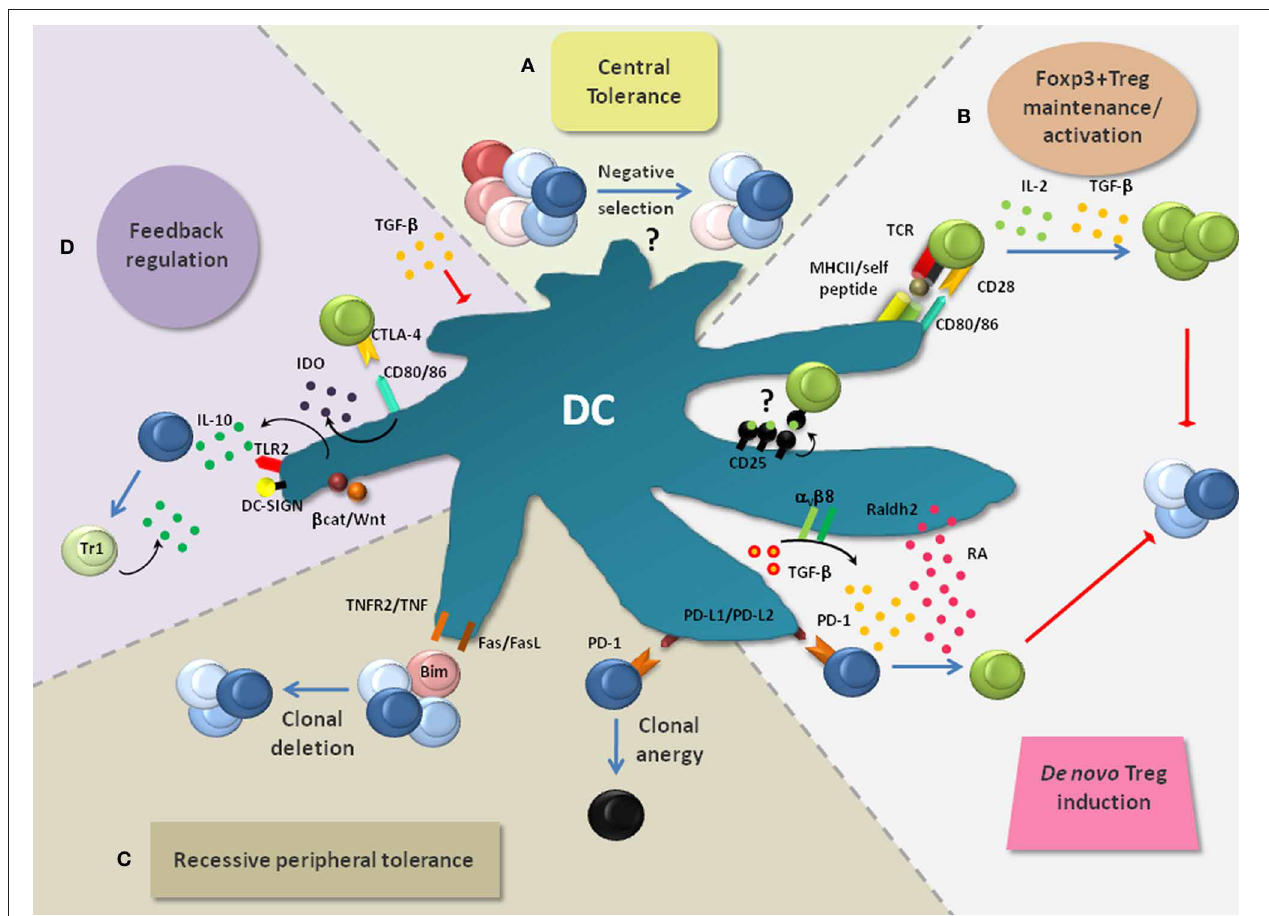
FIGURE 2 | Layers of DC-mediated tolerance. DCs promote tolerance via multiple layers, thereby rendering the term “tolerogenic DC” highly indefinite. (A) DCs are implicated in the negative selection of self-reactive T cells and thus in central tolerance, although this is still a subject of intense research. (B) DCs are critically involved in the de novo generation, homeostasis and activation of Foxp3 + Tregs which play a non-redundant role in the suppression of lethal autoimmunity. Foxp3 + Treg activation by DC-associated MHC-class-II: peptide complexes and CD80/CD86 is crucial